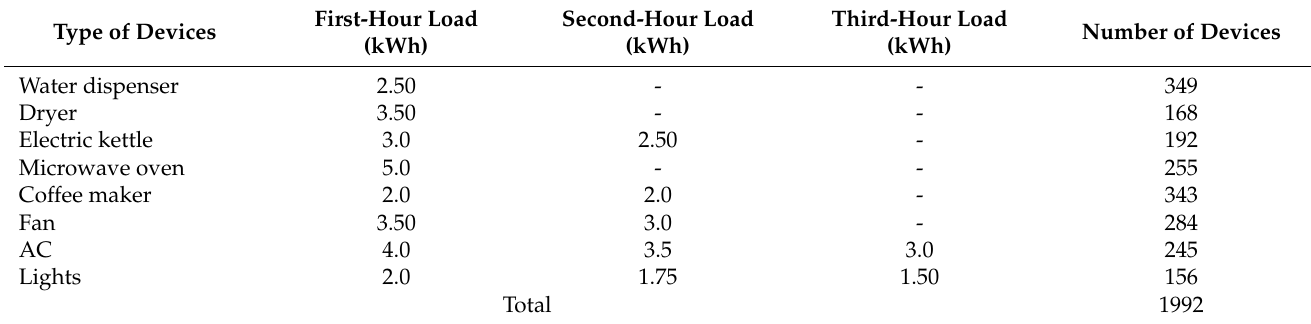
Table 4. Controllable loads present in the commercial